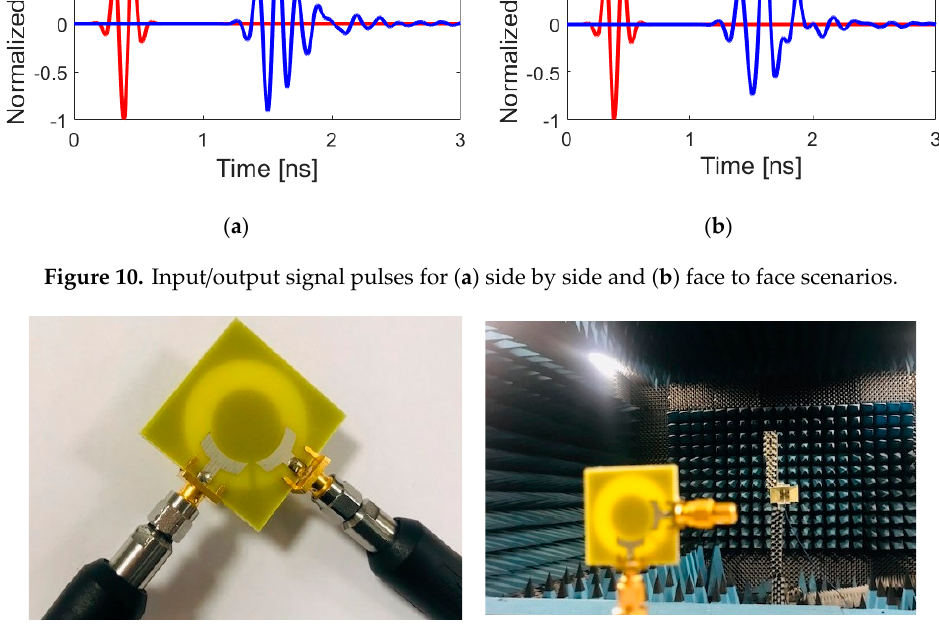
Figure 11. Photographs of the antenna in measurements setup of ( a ) S ‐ parameters and ( b ) radiation patterns. Figure11. Photographsoftheantennainmeasurementssetupof( a )S-parametersand( b )radiationpatterns.